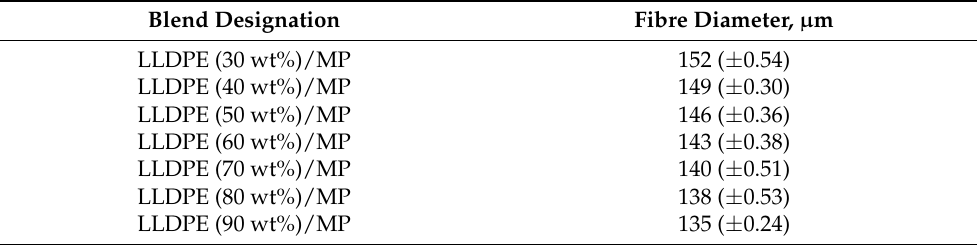
Table 1. LLDPE/MP fibre diameter as a function of LLDPE